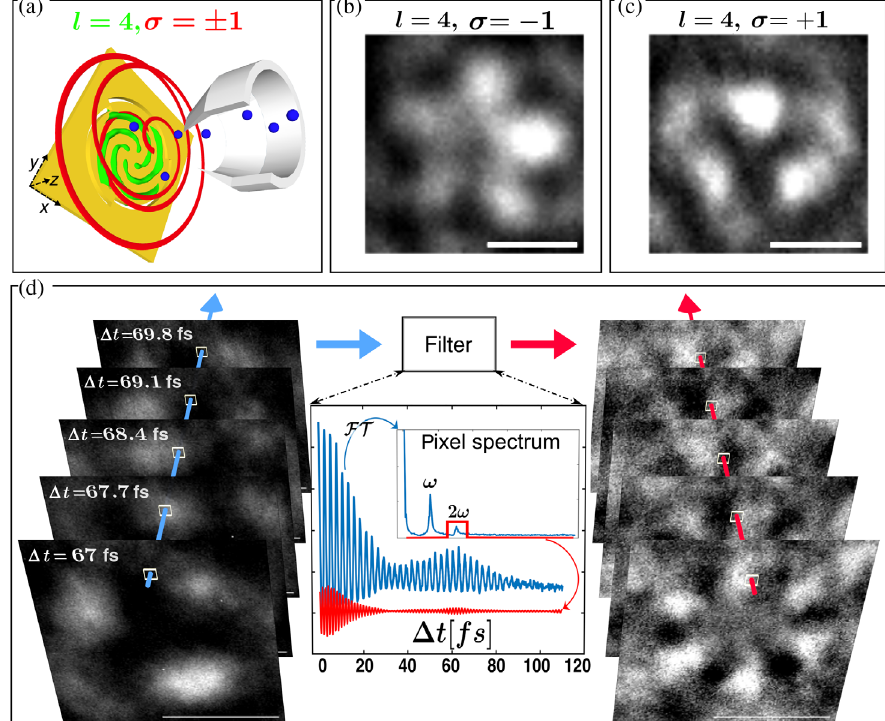
FIG. 1. Experimental concept and results schematic. (a) Plasmonic vortex of order l ¼ 4 (green) revolving on a gold surface and interacting with right or left circularly polarized light pulses ( σ ¼ þ 1 or − 1 ) (red helix). The blue circles represent the photoemitted electrons resulting from two-photon absorption. (b,c) Raw experimental data of delay-time snapshots of electron emission patterns exhibiting an angular distribution of order 5 (b) and 3 (c), indicating the subtraction of the plasmon and light angular momenta. (d) Isolating a double light-plasmon mixing process. The raw data of electron distribution images at varying plasmon-light time delay (left sequence, light-blue guiding arrow) are pixelwise filtered at twice the optical frequency ω (right sequence, red guiding arrow). This case unveils an OAM pattern with twice the lobes of the dominant data. The central graph demonstrates the filtering procedure, taking the raw pixel values for all measured delay values (light blue) and isolating the 2 ω oscillating term (red). The scale bar on all data images is 1